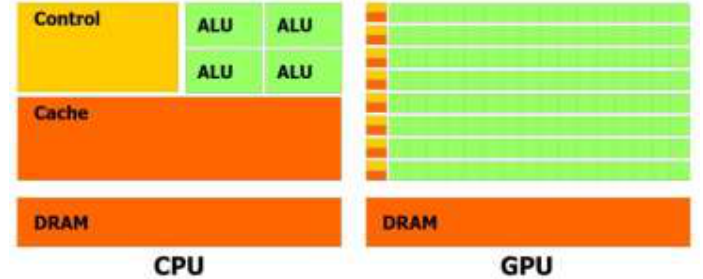
Figure 2. Compare the architecture of CPU and GPU